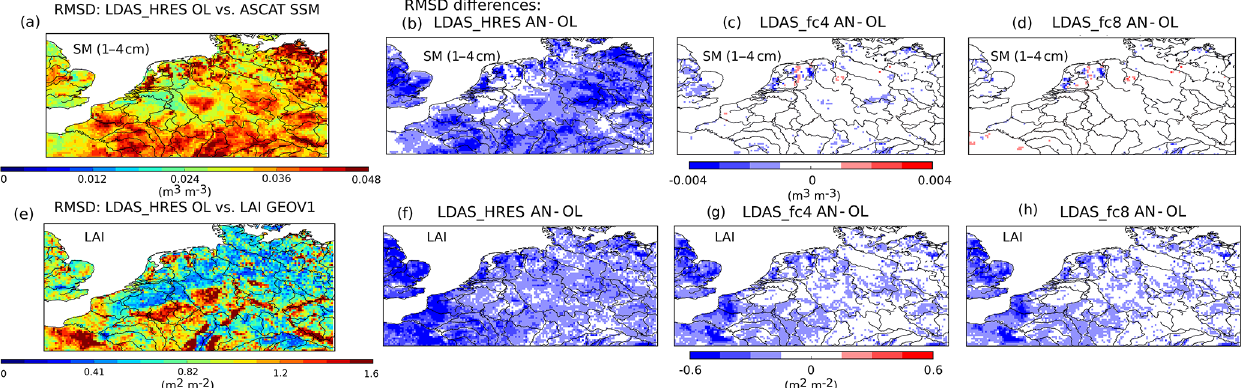
Figure 14. (a) RMSD values between LDAS_HRES open-loop and ASCAT SSM estimates over 2017–2018 for the WEUR domain; (b) RMSD differences between LDAS_HRES analysis (open-loop) and ASCAT SSM. (c) , (d) and (e) : same as (b) between LDAS_fc4 initialized by the analysis (open-loop) and LDAS_fc8. Bottom row: same as the top row for LAI from the different experiments and LAI